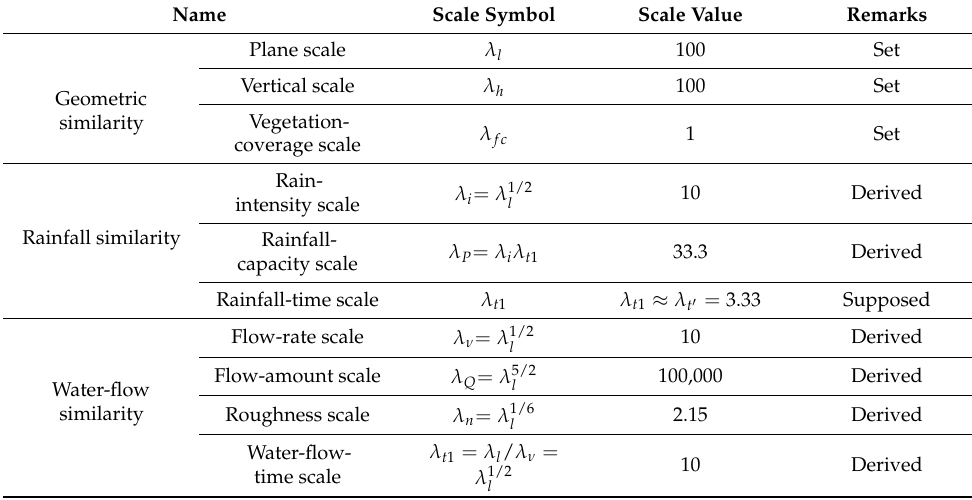
Table 5. Summary of the main scales of the small watershed